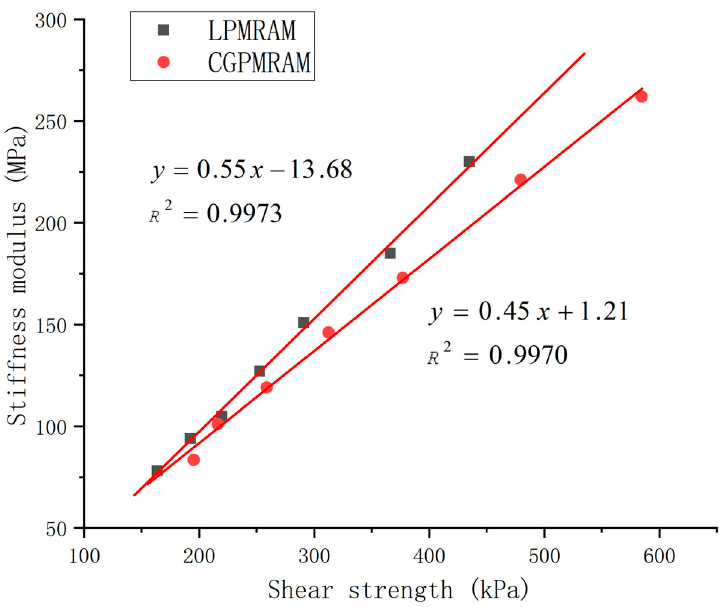
Figure 9. Relationship of high-temperature performance and low-temperature performance of LPMRAM and CGPMRAM.